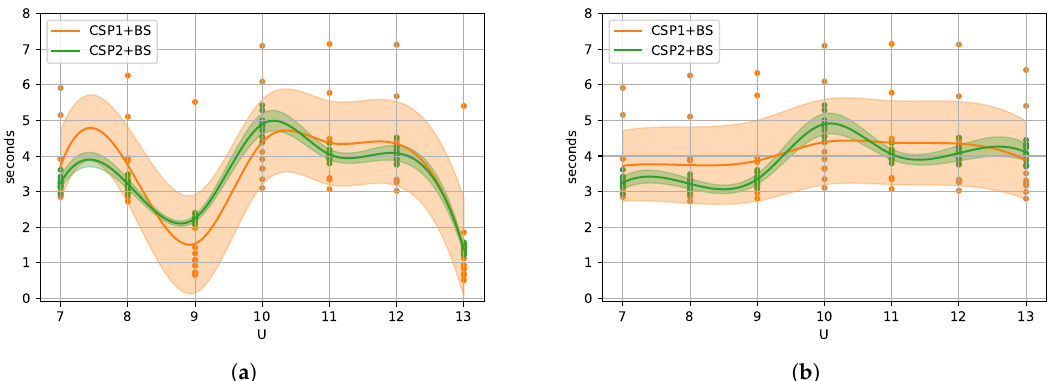
Figure 4. ( a ) Time to the optimal solution and ( b ) to proven optimality reported by Gurobi for the CSP1 + BS and CSP2 + BS over 10 random graphs of order 100, p = 0.023, and b ( G ) = 7. The bounds are L = 1 and U ∈ [ b ( G ) , (cid:100) ( 4 · 100/3 ) 1/2 (cid:101) + 1 ]